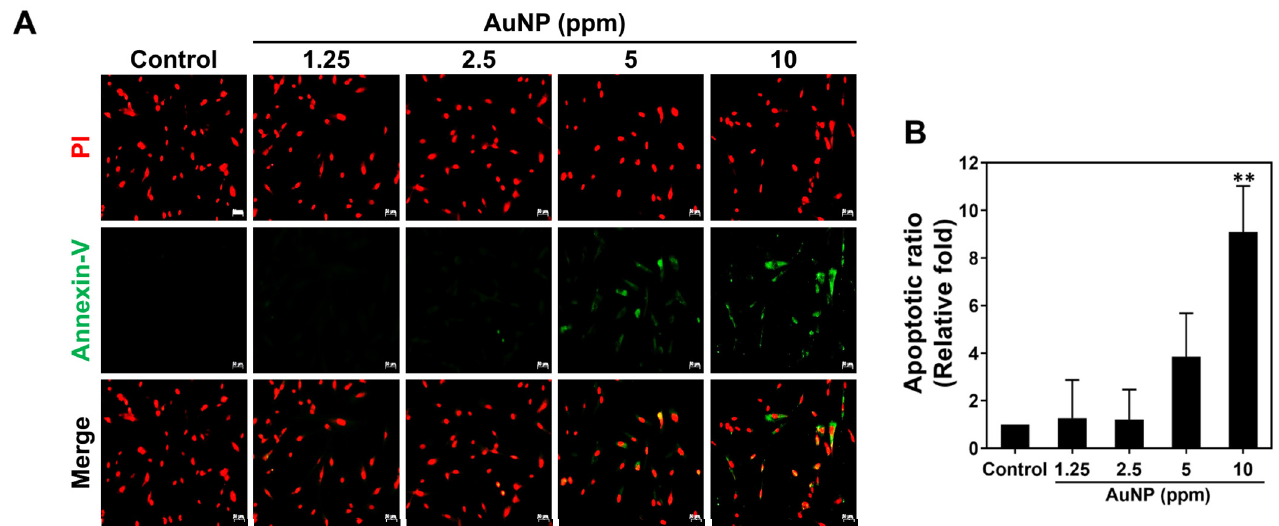
Figure 7. Apoptotic ratio of MSCs visualized via Annexin-V/PI double staining at 48 h. ( A ) The fluorescence images of apoptotic MSCs cultured with various concentrations of AuNPs are shown. ( B ) The apoptotic results in each treatment were semi-quantified based on the green fluorescence intensity, indicating no significant difference in both 1.25 and 2.5 ppm AuNP groups. Scale bars measured as 50 μ m. The images were presented as one of three independent experiments. Data are analyzed as mean ± SD ( n = 3). ** p < 0.01: compared to the Control group (TCPS).